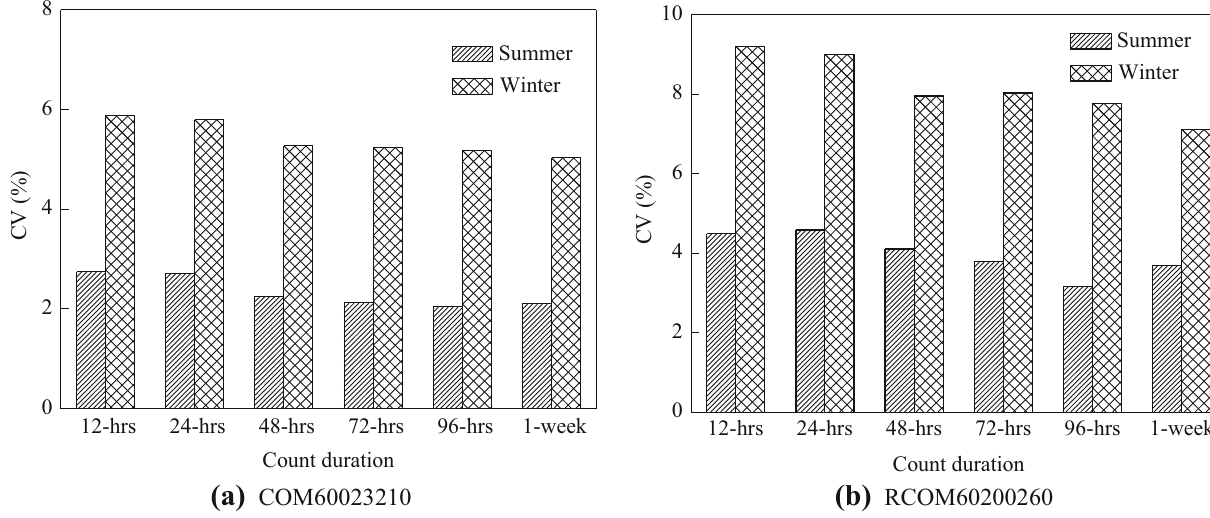
Fig. 3 Average CV values for all SDCs during summer and winter